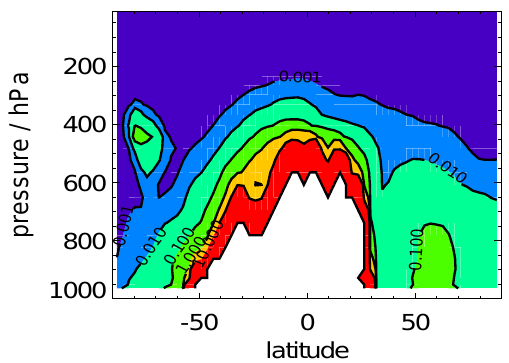
Figure 5. Percentage contribution of PBAPs (bacteria and fungal spores) to zonal annual mean all-sky immersion freezing rates. Values are for the upper limit contribution of PBAPs to immer- sion freezing (see text). White colour shows where total immersion freezing rate is less than 1 × 10 − 14 cm − 3 s − 1 .